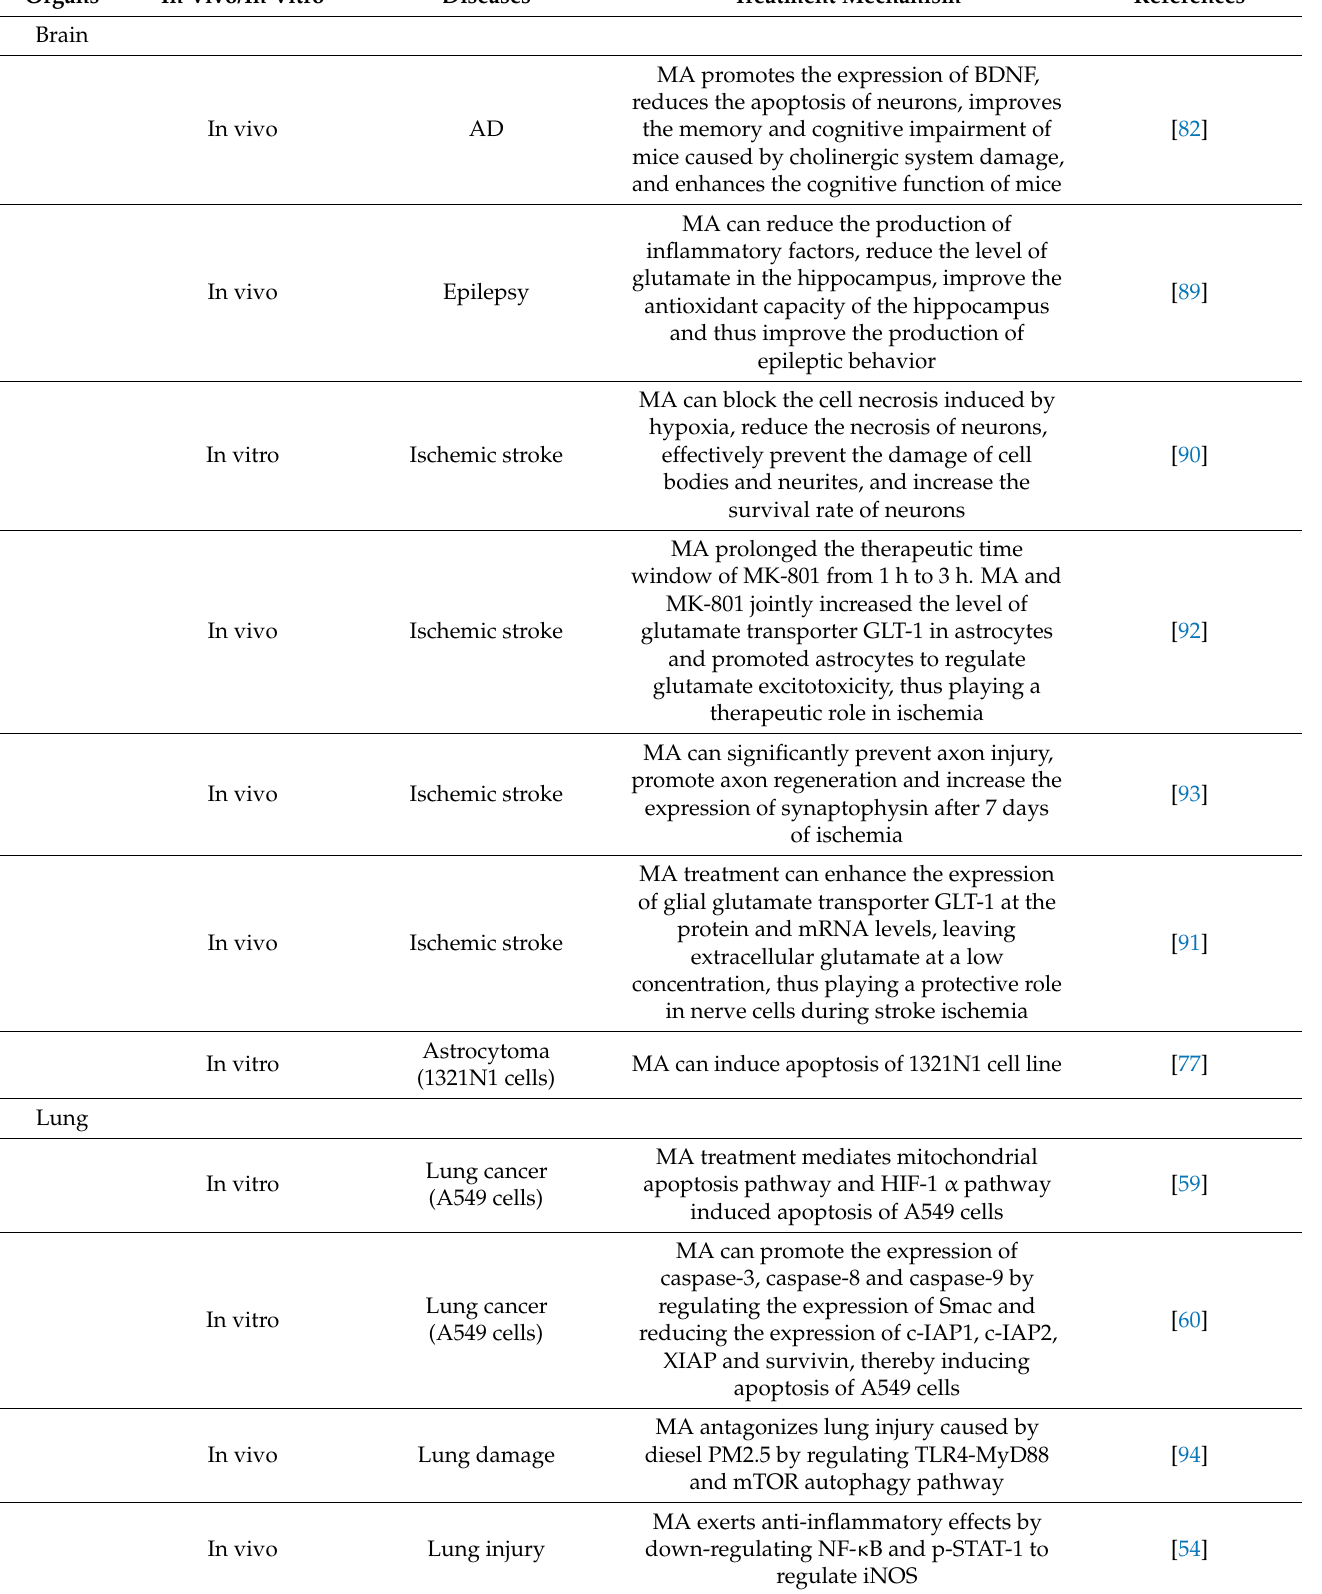
Table 1. The treatment mechanism of MA in treating diseases of various organs are